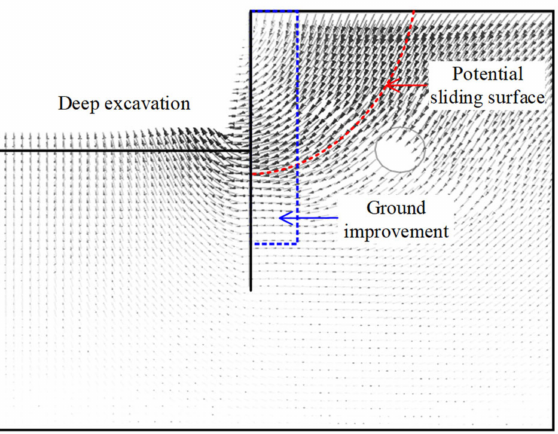
Figure 12. Relative positions between ground improvement and potential sliding